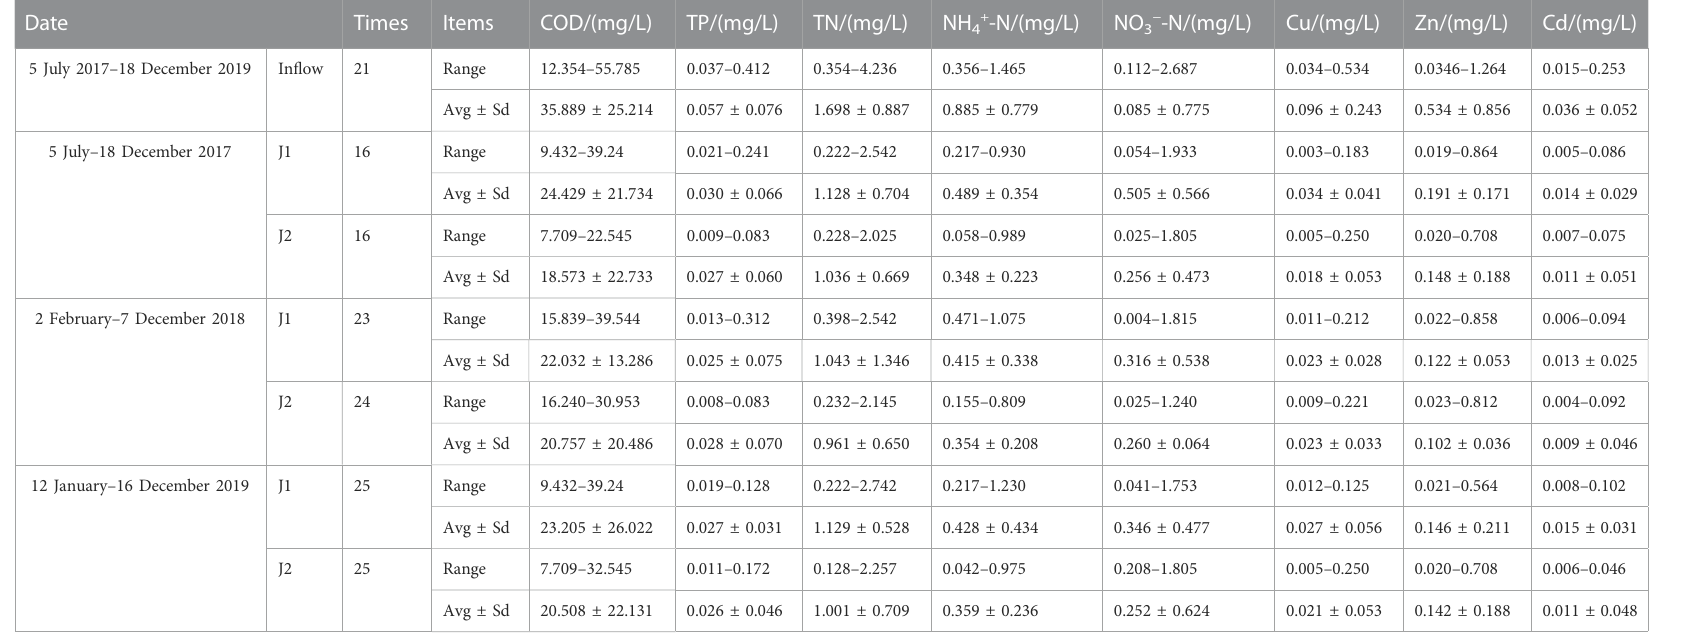
TABLE 4 Groundwater